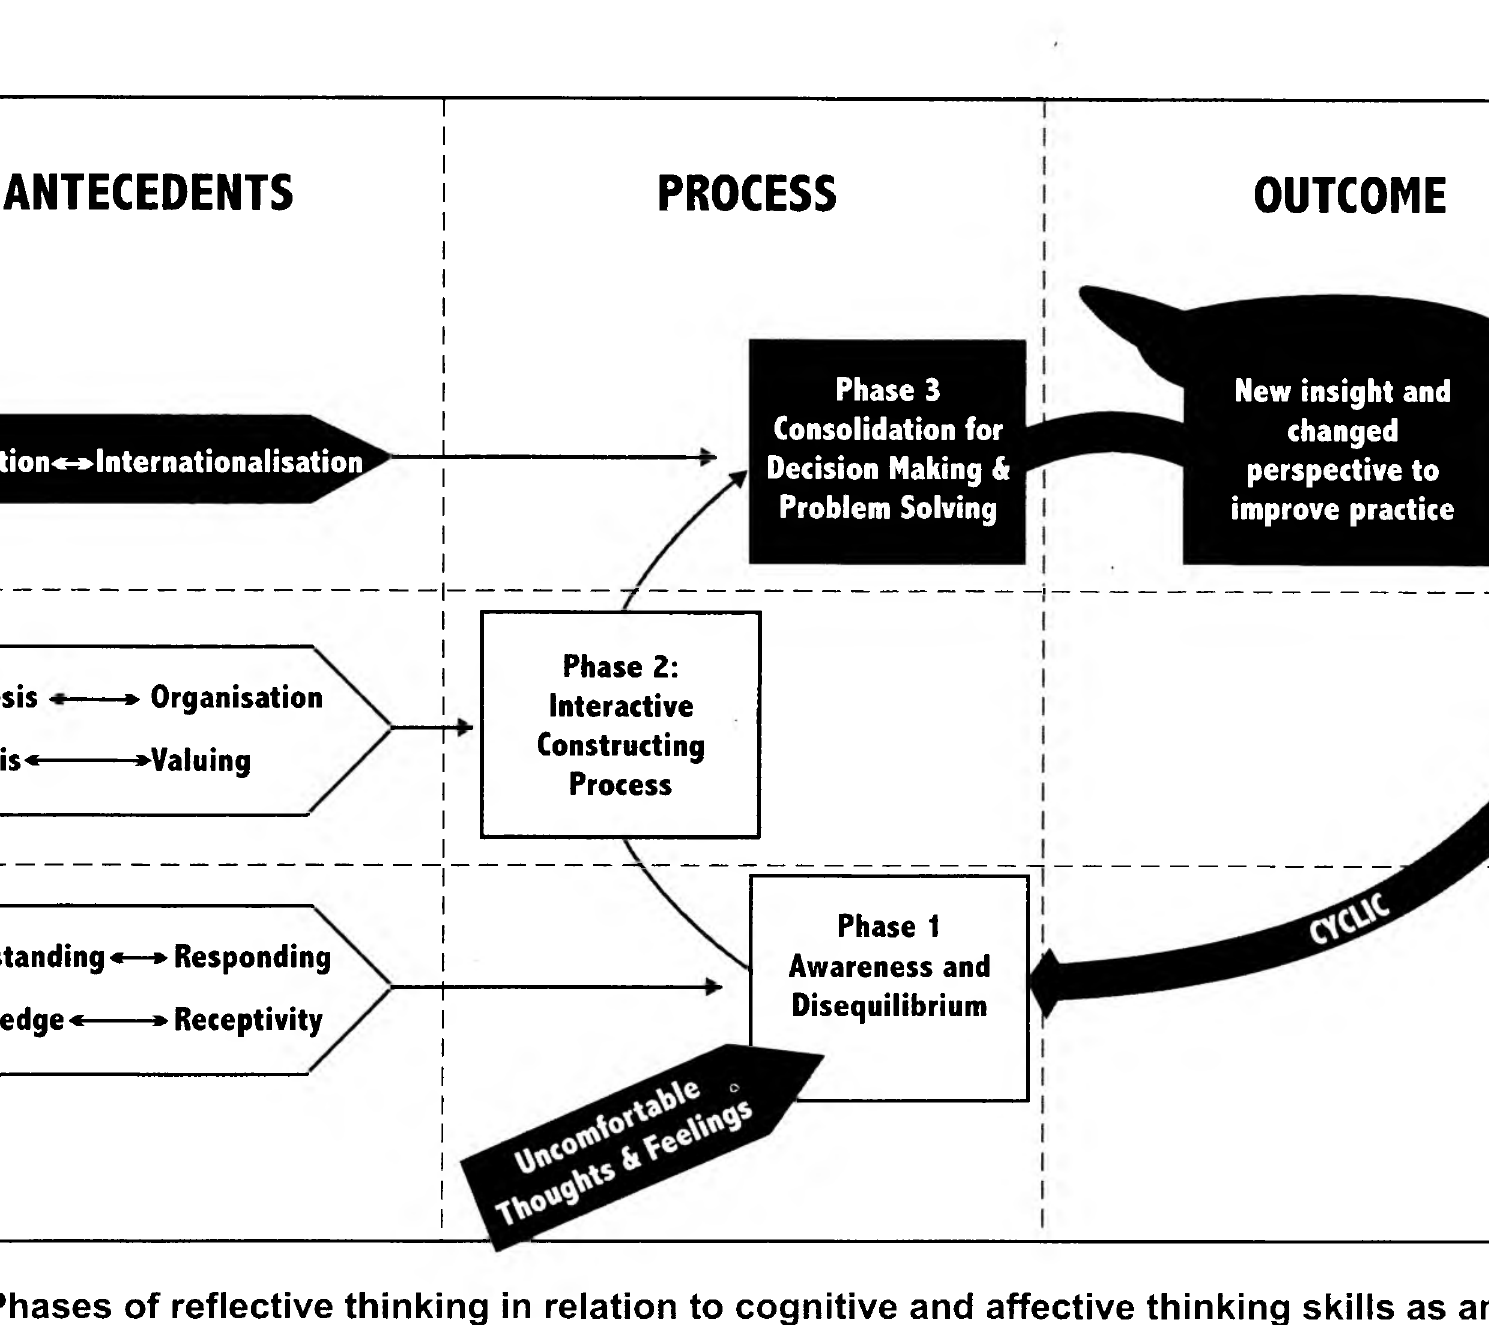
Figure 1: Phases of reflective thinking in relation to cognitive and affective thinking skills as